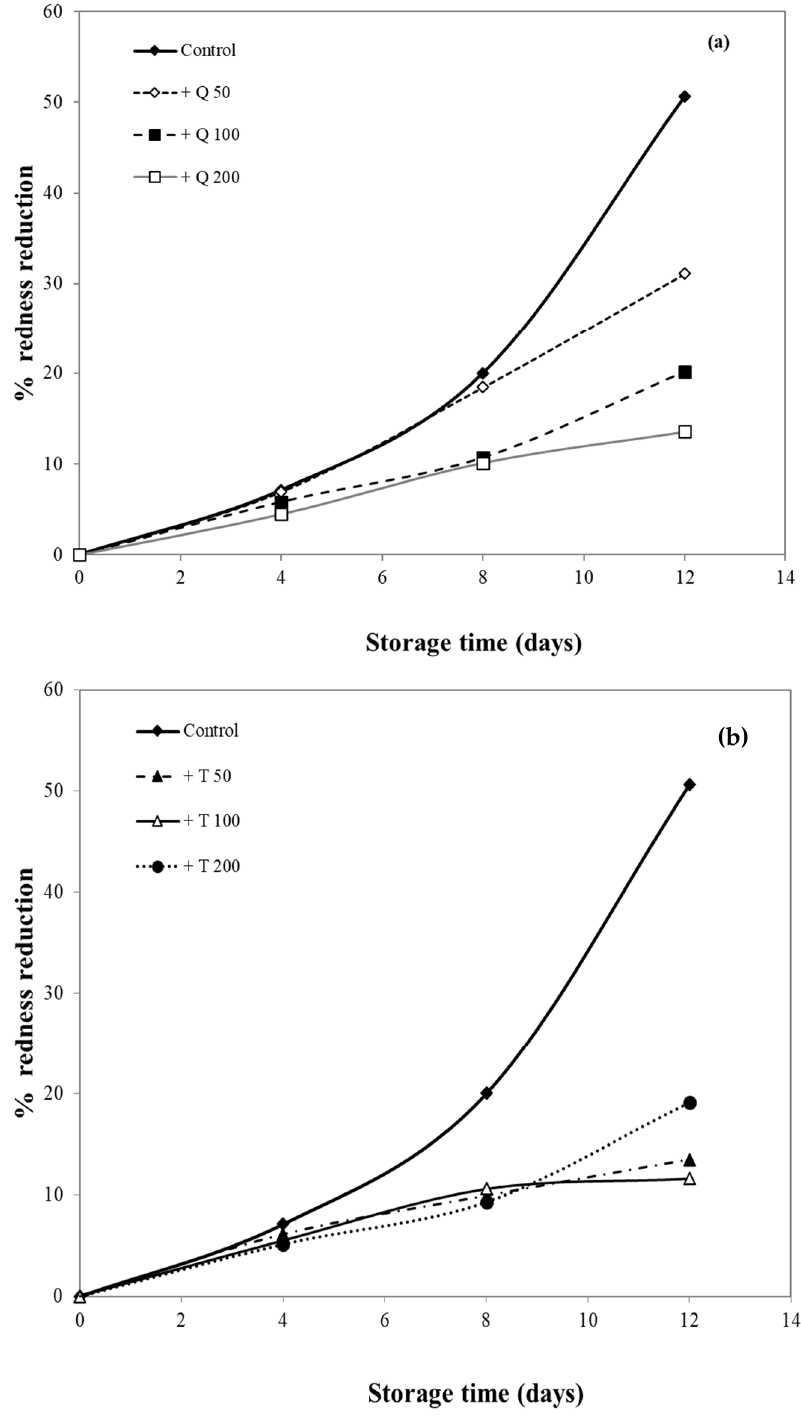
Figure 10. Effect of antioxidant (( a ) quercetin and ( b ) TBHQ) addition into cassava starch/gelatin film on the percentage redness decrease of pork compared to uncovered (control).